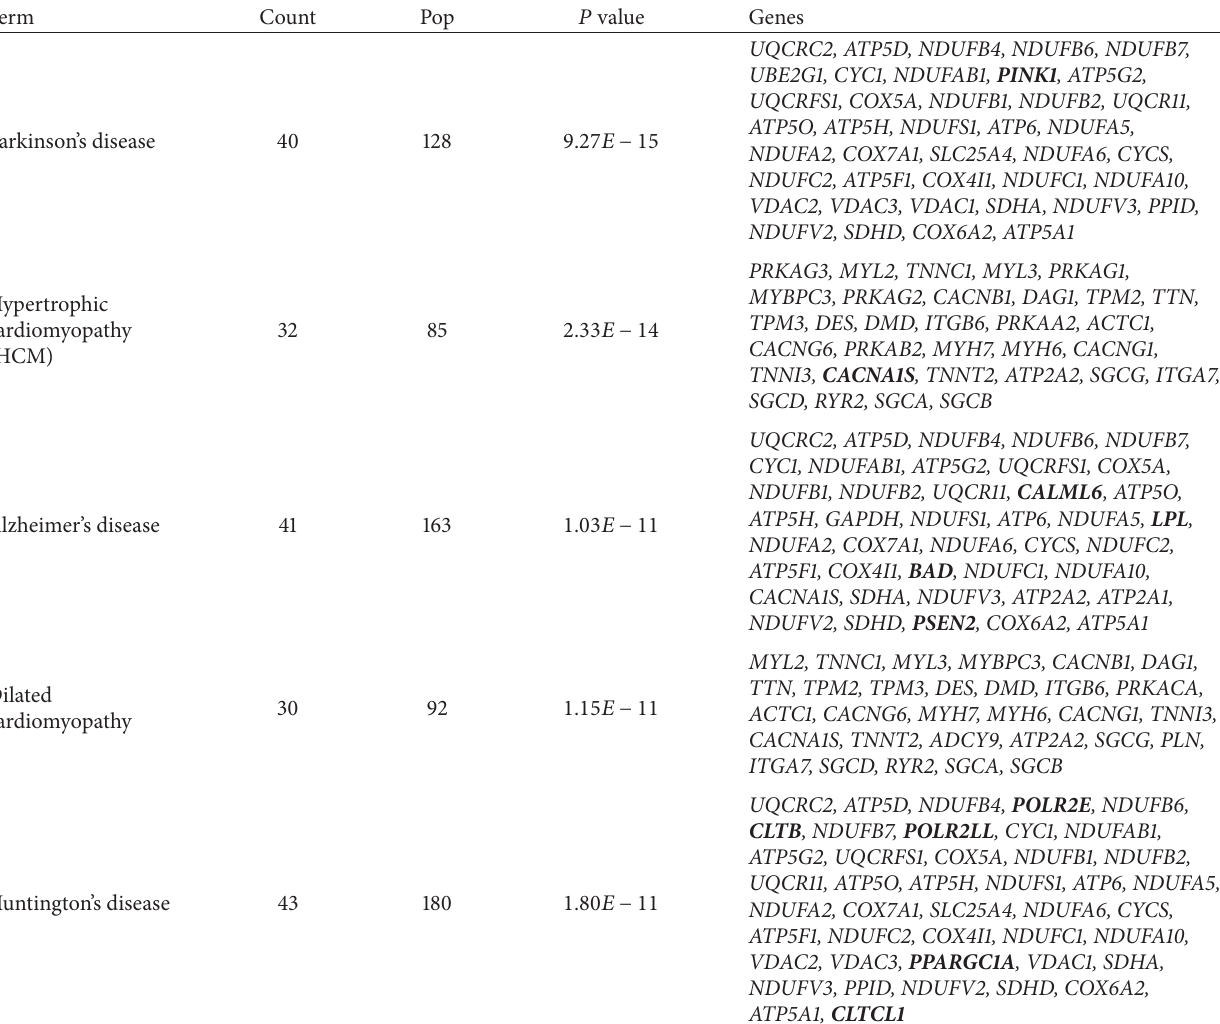
Table 3: KEGG enrichment analysis of genes coexpressed with